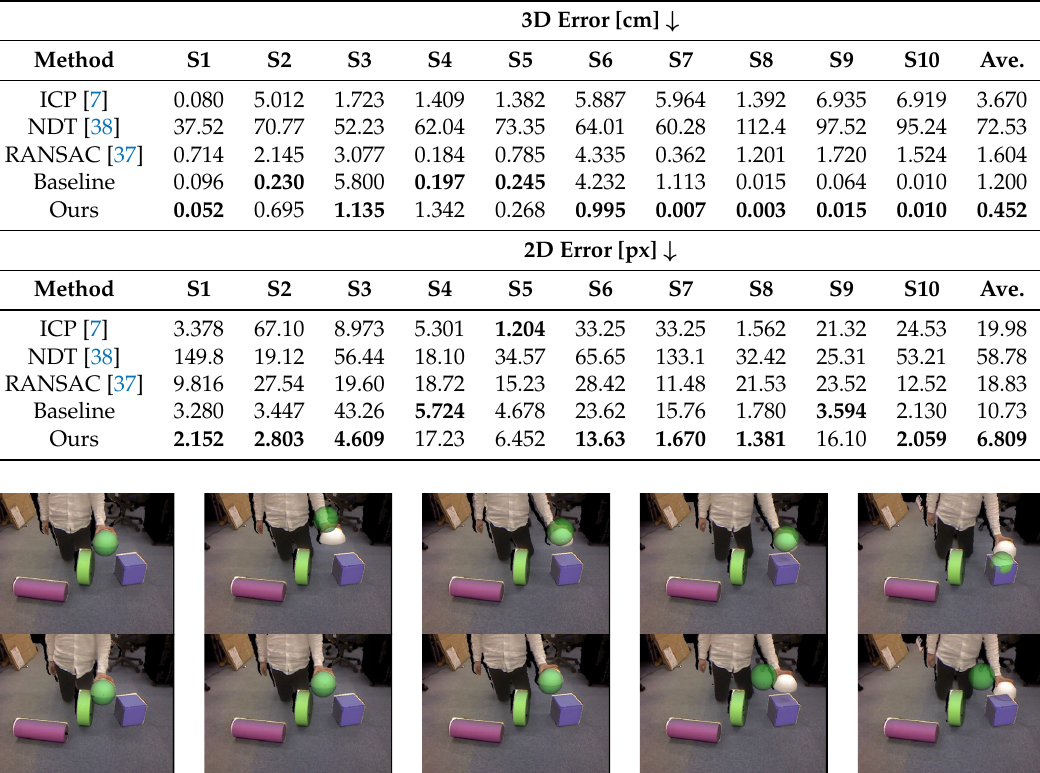
Table 2. Error of primitive shape pose estimation (per scene) using our dataset. S1 to S10 denotes the indices of the scene in the dataset. The rightmost column shows the average of entire scenes.